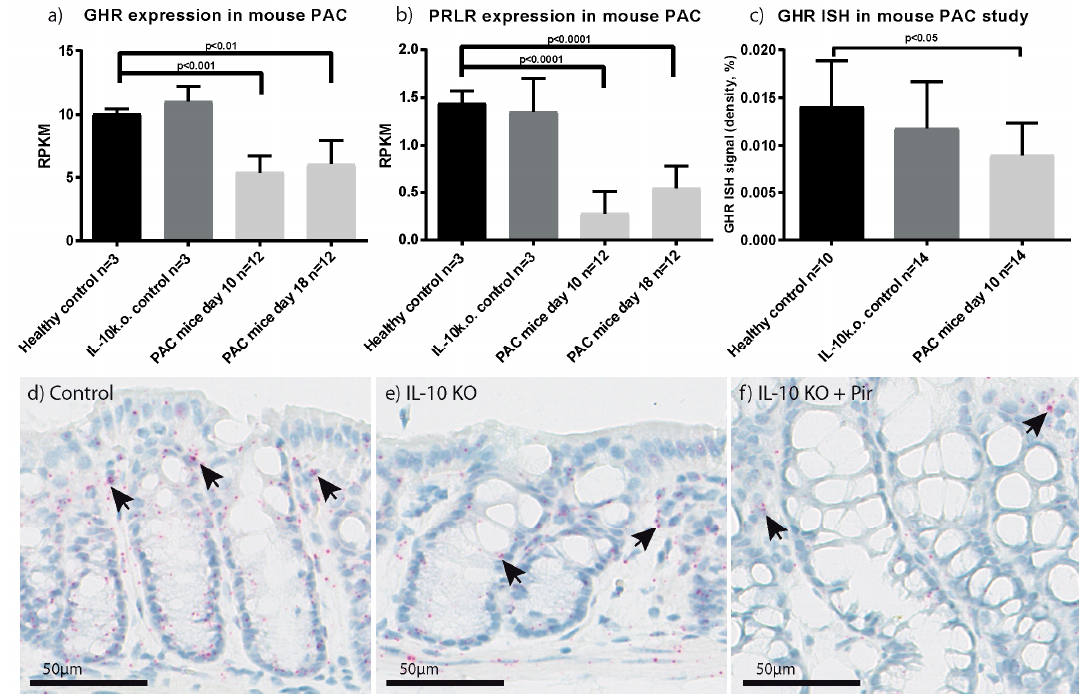
Figure 3. Colonic samples from the piroxicam accelerated colitis (PAC) model analyzed for expression of mouse growth hormone receptor (mGHR) ( a ) and mouse prolactin receptor (mPRLR) ( b ) by RNA seeq. Samples were obtained from healthy controls, IL-10 k.o. animals and after the indicated number of days following induction of disease using piroxicam; ( c ) Quantification of the in situ hybridization performed in the PAC model at day 10 ( d – f ). Arrows indicate positively stained cells. Data presented as mean ± SD. Statistics: Ordinary one way ANOVA with Holm Sidak’s correction comparing healthy control to all other groups.